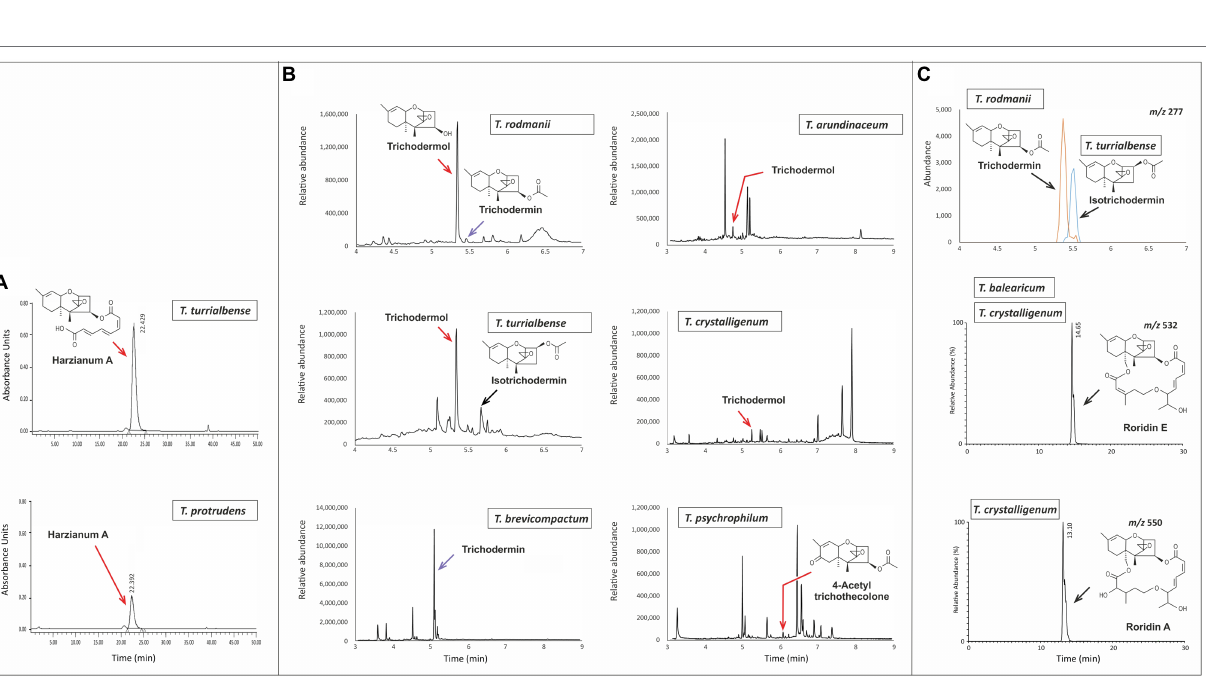
FIGURE 3 | Analysis of trichothecene production in selected Trichoderma species. (A) Chromatograms from HPLC-UV analysis for determination of harzianum A production by T. turrialbense and T. protrudens . (B) Chromatograms from GC–MS analysis for production of multiple trichothecenes by T. arundinaceum , T. brevicompactum , T. crystalligenum , T. psychrophilum , T. rodmanii , and T. turrialbense . (C) Chromatograms from LC–MS analysis for detection of multiple trichothecenes: m/z 277 (upper panel) for detection of trichodermin and isotrichodermin production by T. rodmanii (5.4 min peak) and T. turrialbense (5.5 min peak); m/z 532 (middle panel) for detection of the [M + NH 4 ] + ion of roridin E produced by T. balearicum and T. crystalligenum ; and m/z 550 (bottom panel) for detection of the [M + NH 4 ] + ion of roridin A produced by T. crystalligeum . Mass spectra for compounds shown in (C) are included in Supplementary Figure S2